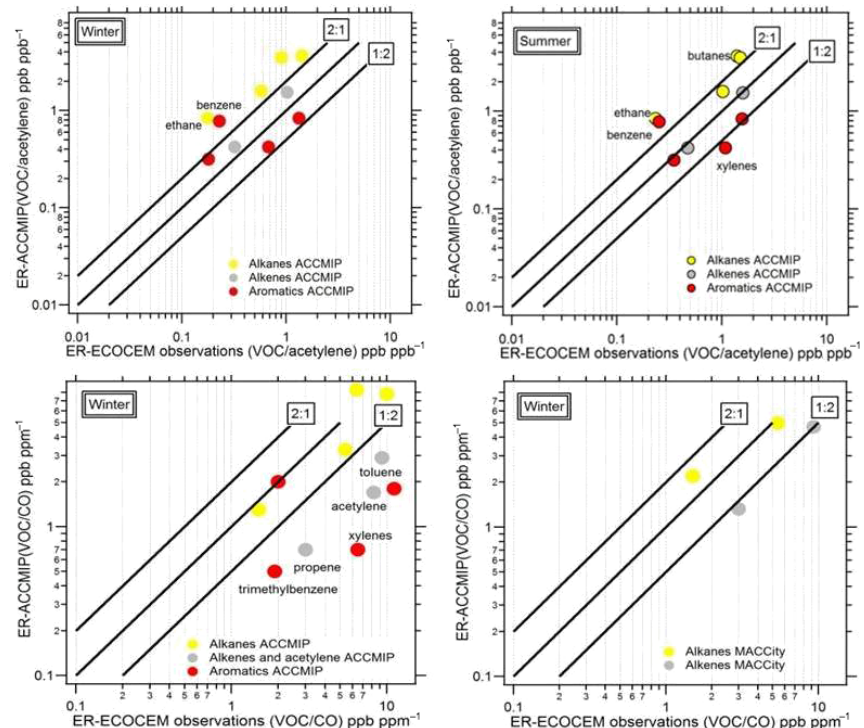
Figure 8. Comparison of the emission ratios from ACCMIP and MACCity to the ones measured by LRF method in summer and in winter relative to CO and acetylene for all the anthropogenic